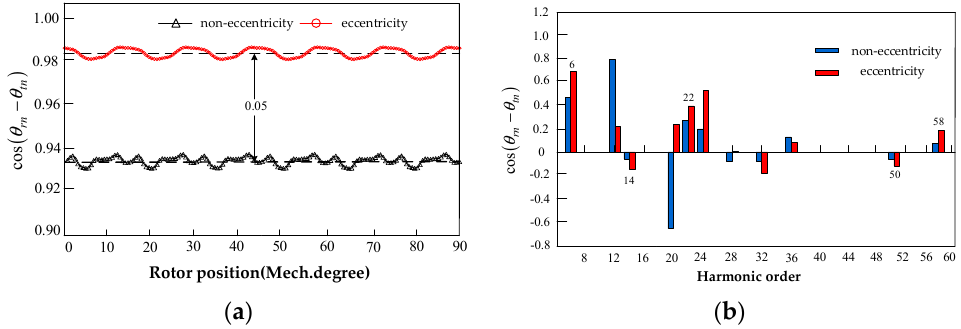
Figure 10. Phase angle difference cosine values of radial and tangential magnetic density harmonic: ( a ) the phase angle difference cosine value of the fundamental component and ( b ) the cosine value of the phase angle difference for each harmonic.